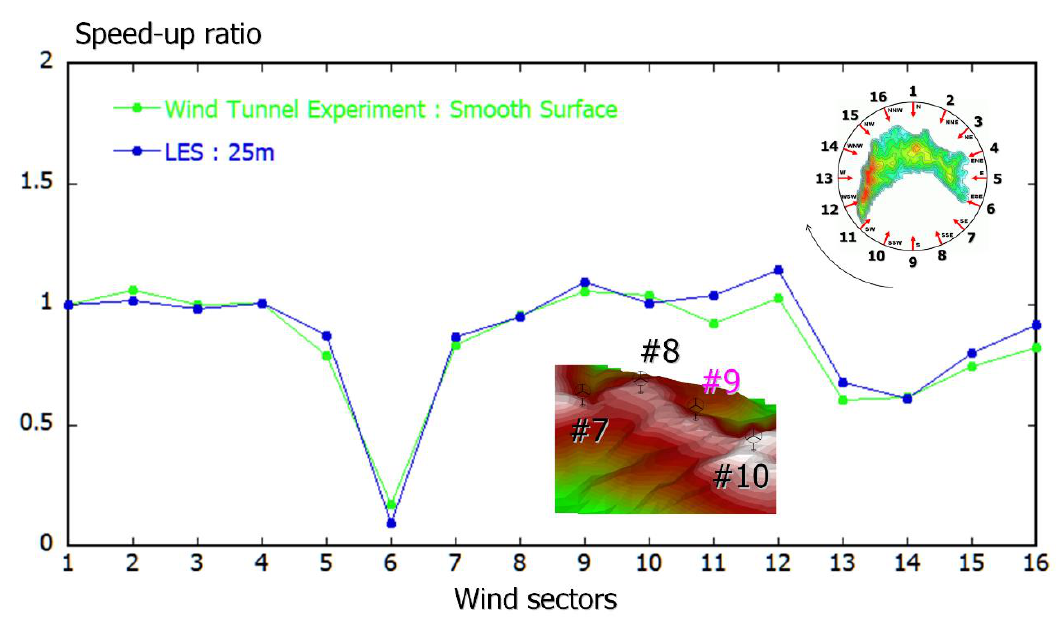
Figure 37. Comparison of local speed-up ratios at WT #9 hub height obtained by wind tunnel experiments and numerical simulations for 16 wind sectors.